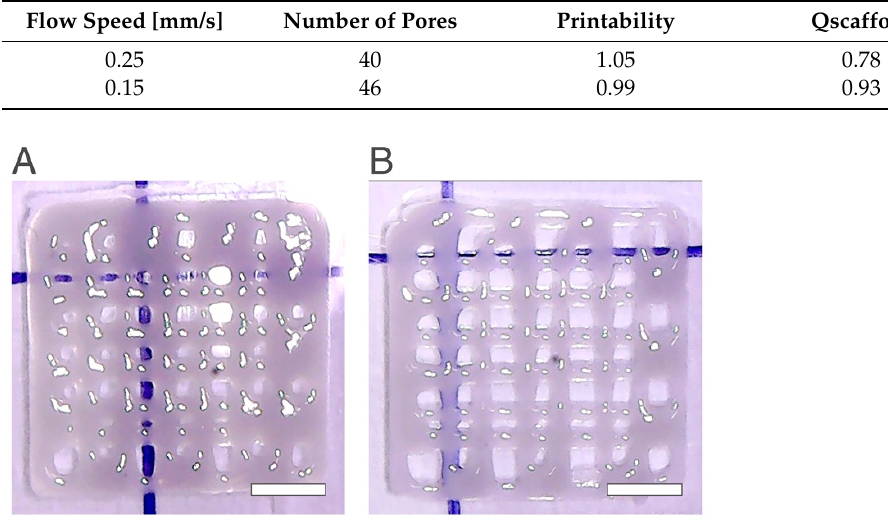
Figure 6. Printed scaffolds with 2.5 wt% chitosan and 13 wt% starch with different flow speed values ( A ) 0.25 mm/s ( B ) 0.15 mm/s . The scale bars measure 5 mm. ( A ) 0.25 mm/s ( B ) 0.15 mm/s. The scale bars measure 5